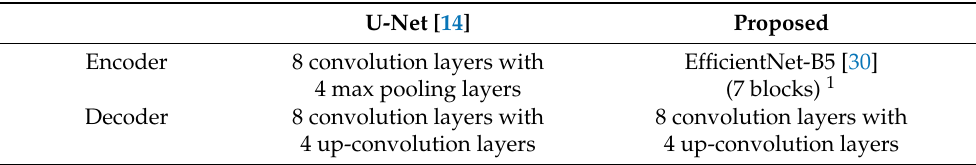
Table 1. The difference between U-net and proposed